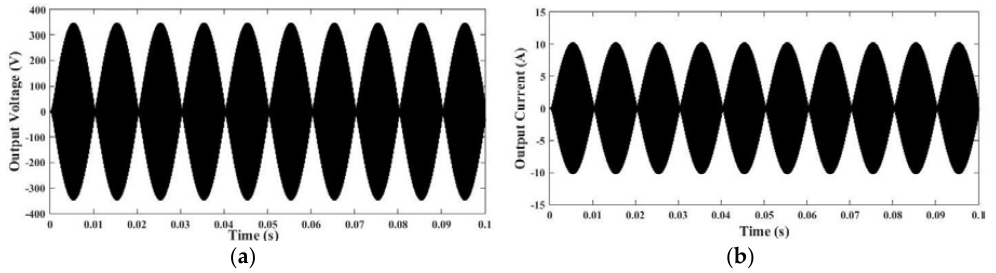
Figure 9. Simulated waveforms of ( a ) Output voltage ( V out ) and ( b ) Output current ( I out ) at 100 Hz.